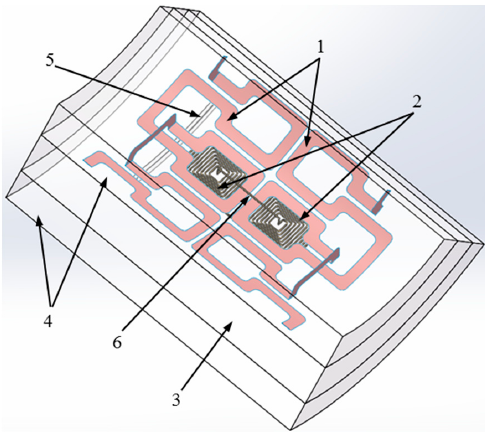
Figure 3. Simulation model of the sensor. 1—Excitation traces; 2—Sensing traces; 3—Segment of hollow axle; 4—Air; 5—Artificial Defect; 6—Lumped element .